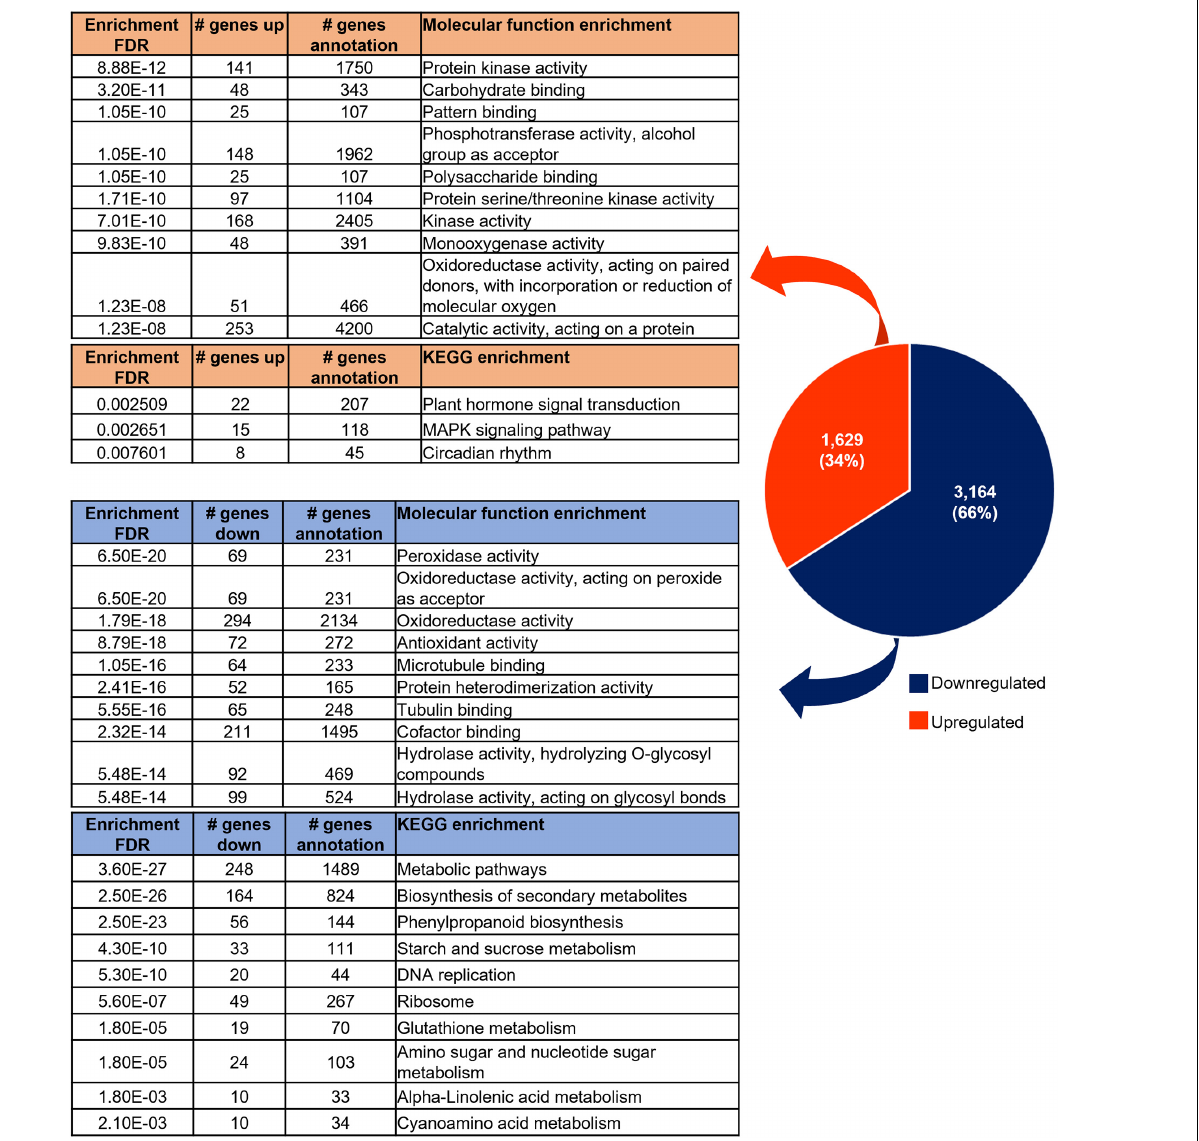
FIGURE 2 | Number of up or downregulated differentially expressed genes (DEGs) and their associated functional enrichment.